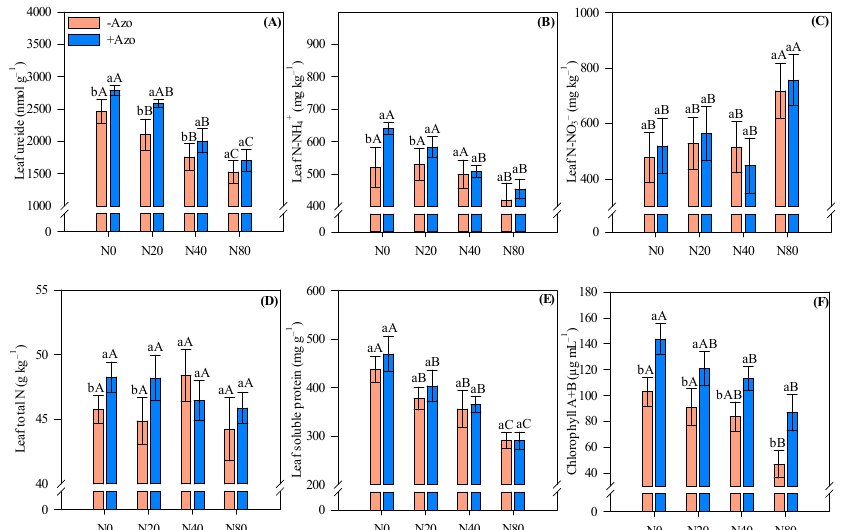
Figure 2. Leaf ureides ( A ), ammonium (N-NH 4+ ) ( B ), nitrate (N-NO 3 − ) ( C ), total N ( D ), soluble protein ( E ) and chlorophyll A + B ( F ) concentrations in cowpea affected by inoculations and N fertilizer rates. Different letters indicate significant differences between treatments according to Tukey’s test ( p ≤ 0.05). Interaction between inoculations and N levels: Lowercase letters indicate significant differences between inoculations, and uppercase letters indicate significant differences between N levels according to Tukey’s test ( p ≤ 0.05). Error bars indicate standard deviations ( n = 4). − Azo and +Azo refer to the single inoculation with Bradyrhizobium sp. and co-inoculation with Bradyrhizobium sp. + A. brasilense , respectively; N0, N20, N40 and N80 refer to absence, 20, 40 and 80 kg N ha − 1 applied.